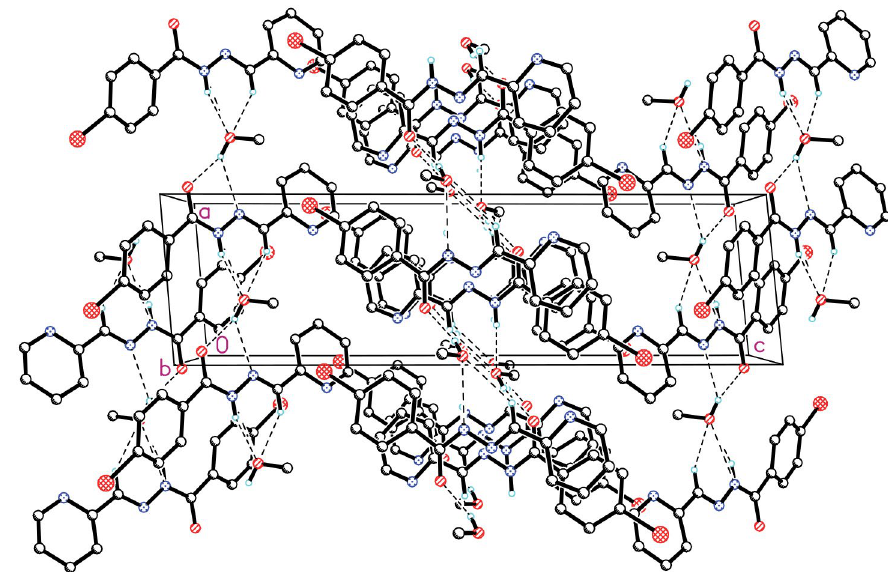
Figure 2. Molecular packing diagram of HL, viewed along the b axis. Hydrogen bonds are shown as dashed lines.